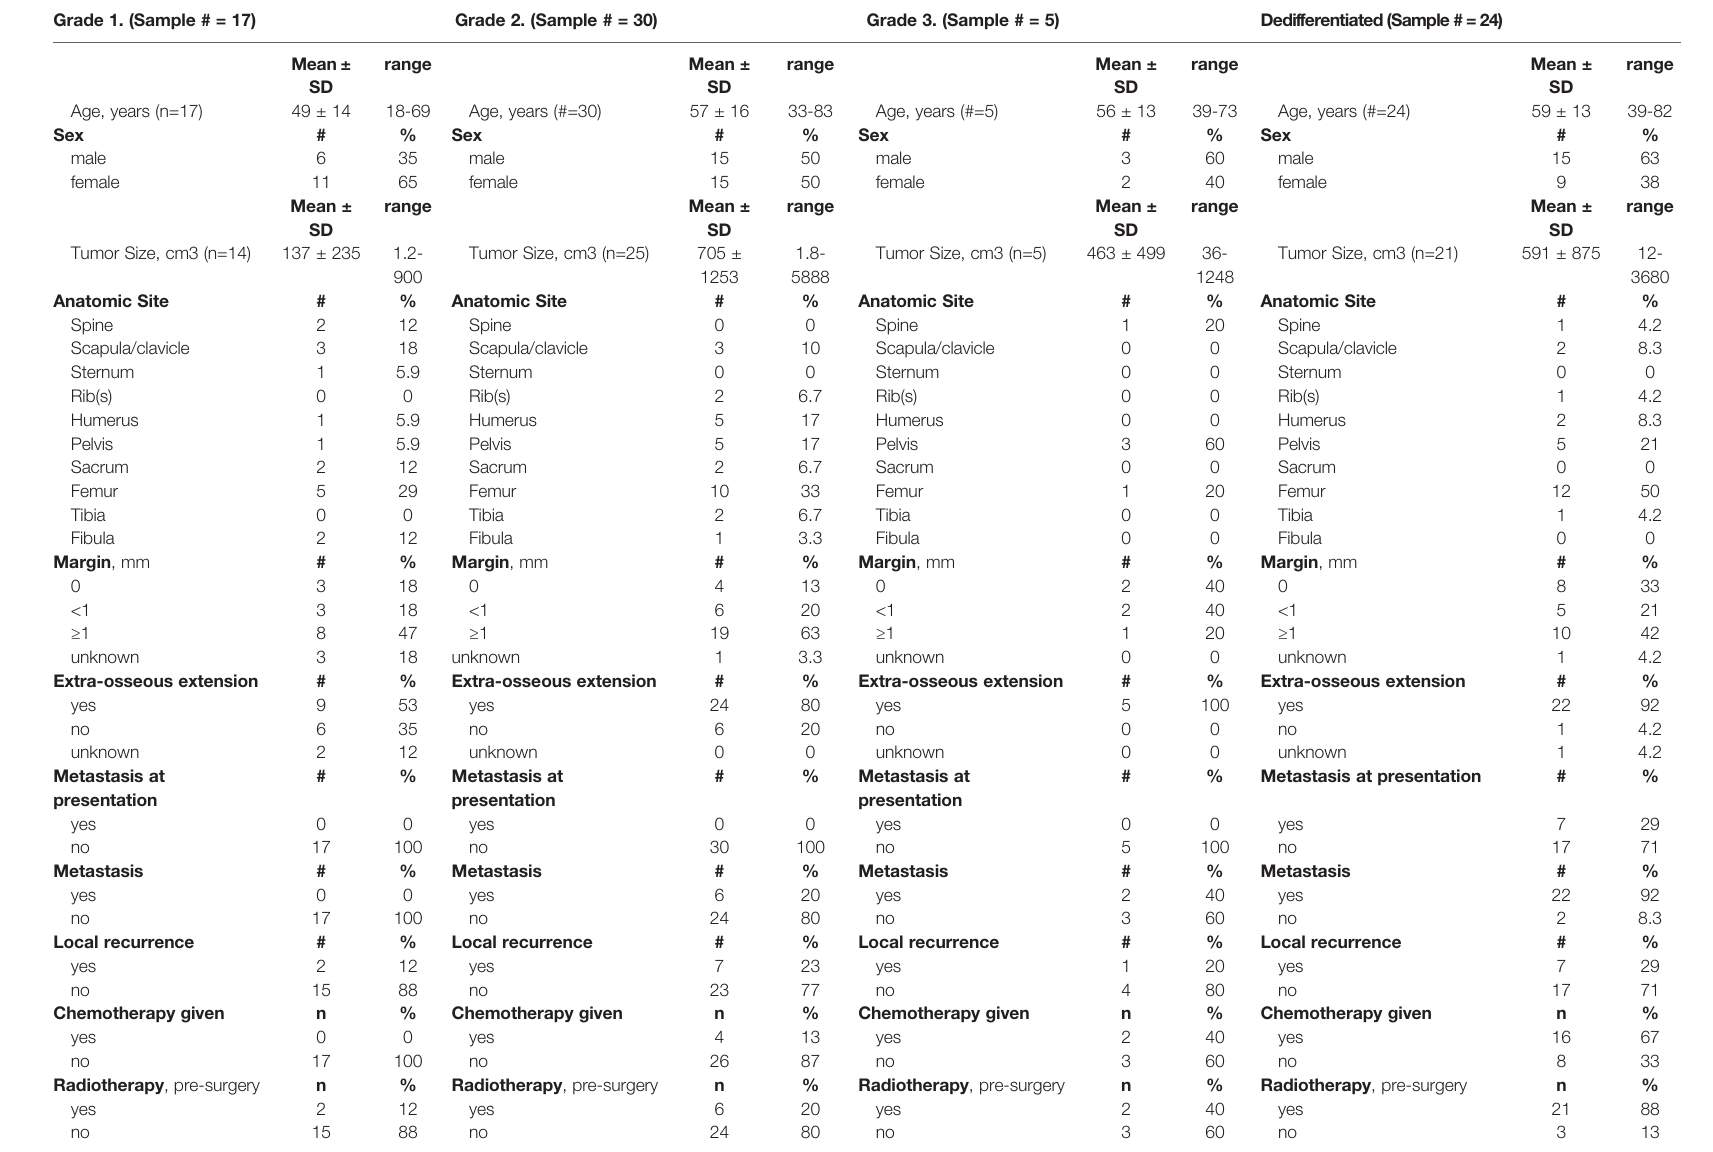
TABLE 1 | Clinical and pathological characteristics of the analyzed chondrosarcoma tumors. Grade 1. (Sample # =